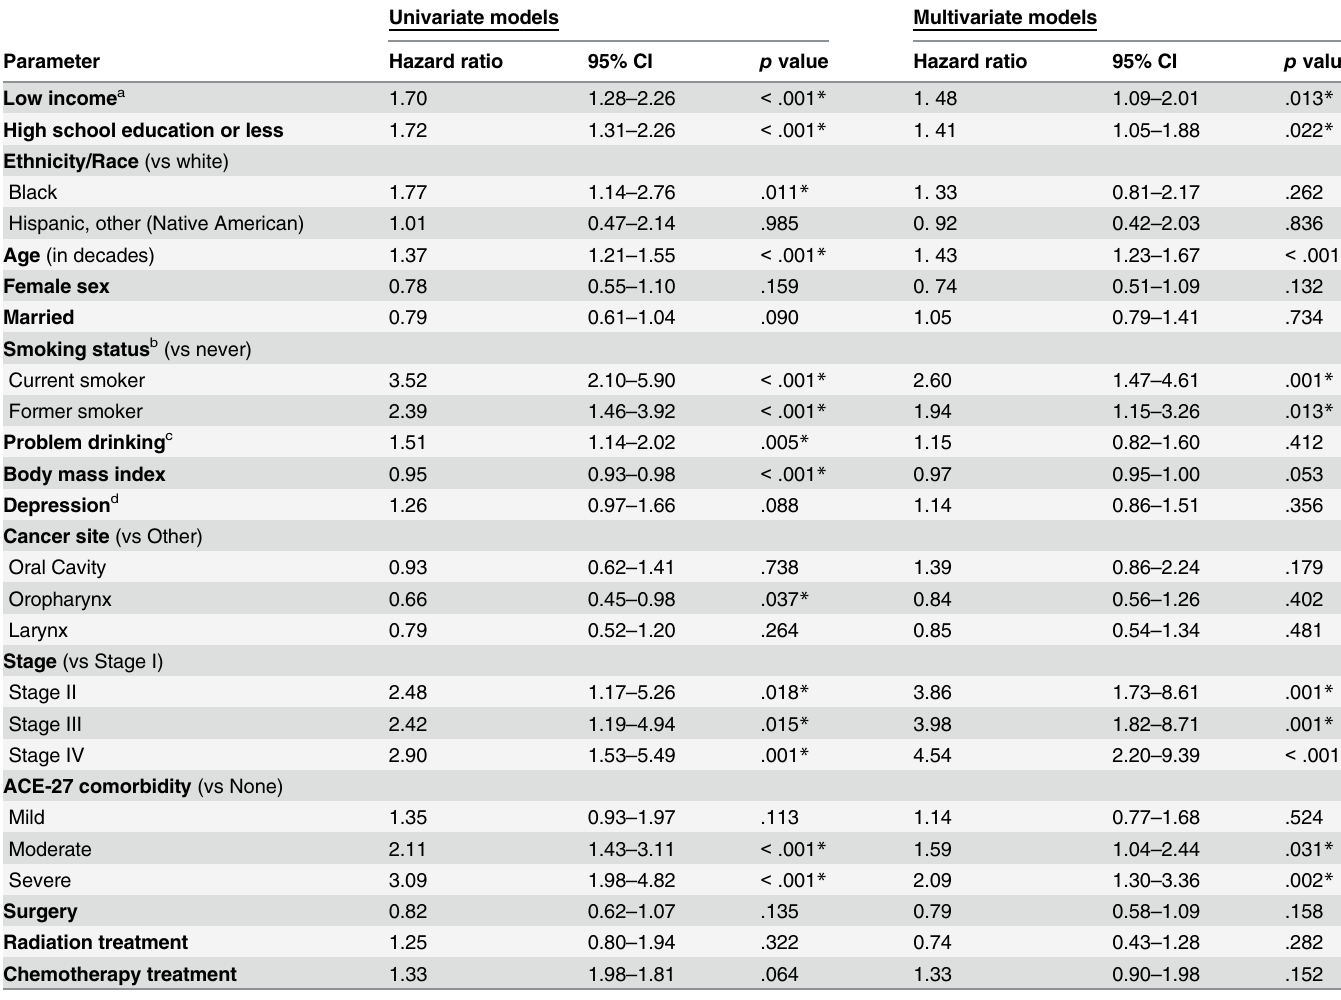
Table 3. Univariate and multivariate Cox proportional hazards model for 5-year overall survival. (N = 634 [216 events, 418 censored]). Univariate models Multivariate